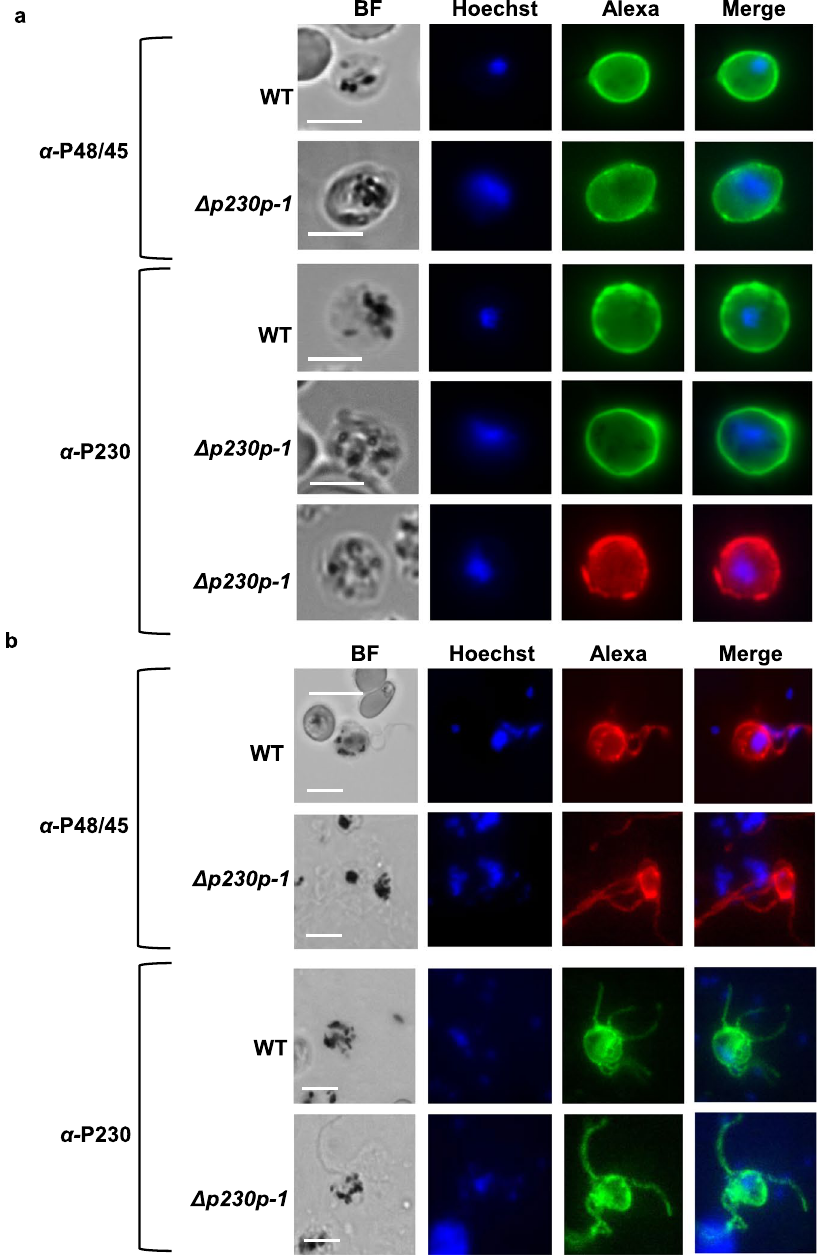
Figure 3. Expression of P230 an P48/45 in activated female and male gametes of Pf Δ p230p-1 . ( a ) Immunofluorescence analyses of female gametes 30 minutes after gametocyte activation in fetal calf serum. Unfixed parasites were labelled with mouse anti-P230 (MAb 63F2A2) or rat anti-P48/45 (MAb 85RF45.1) antibodies followed by secondary conjugated antibodies (i.e. anti-rat, anti-mouse IgG Alexa Fluor ® 488 (green) or anti- mouse IgG Alexa Fluor ® 594 (red)). Nuclei stained with the DNA-specific dye Hoechst-33342. All pictures were recorded with standardized exposure/gain times; Alexa Fluor ® 488 (green) 0.7 s; anti- IgG Alexa Fluor ® 594 (red) 0.6 s; Hoechst (blue) 0.136 s; bright field 0.62 s (1x gain). Scale bar, 7 µ m. ( b ) Immunofluorescence analyses of male gametes 15 minutes after gametocyte activation in fetal calf serum. Cells were fixed with methanol and labelled with mouse anti-P230 (MAb 63F2A2) or rat anti-P48/45 (MAb 85RF45.1) antibodies followed by secondary conjugated antibodies (i.e. anti-mouse IgG Alexa Fluor ® 488 (green) or anti-rat IgG Alexa Fluor ® 594 (red)). Nuclei stained with the DNA-specific dye Hoechst-33342. All pictures were recorded with standardized exposure/gain times; Alexa Fluor ® 488 (green) 0.7 s; anti-IgG Alexa Fluor ® 594 (red). 0.6 s; Hoechst (blue) 0.136 s; bright field 0.62 s (1x gain). Scale bar, 7 µ